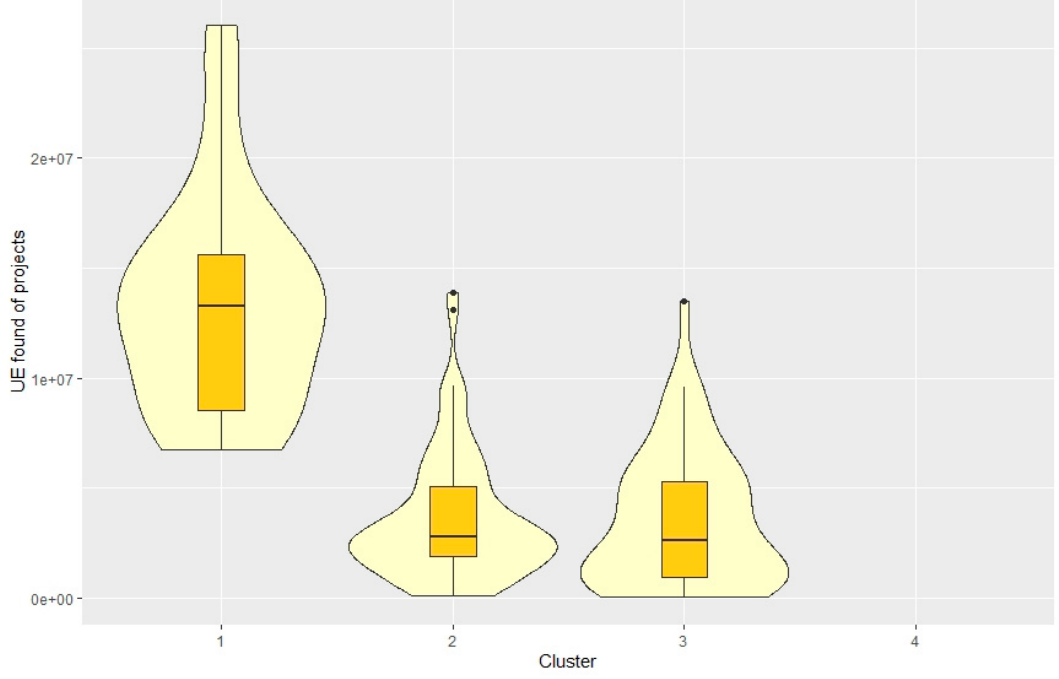
Figure A5. Violin plots for EU funds of solar projects in clusters, cluster 4–no projects.